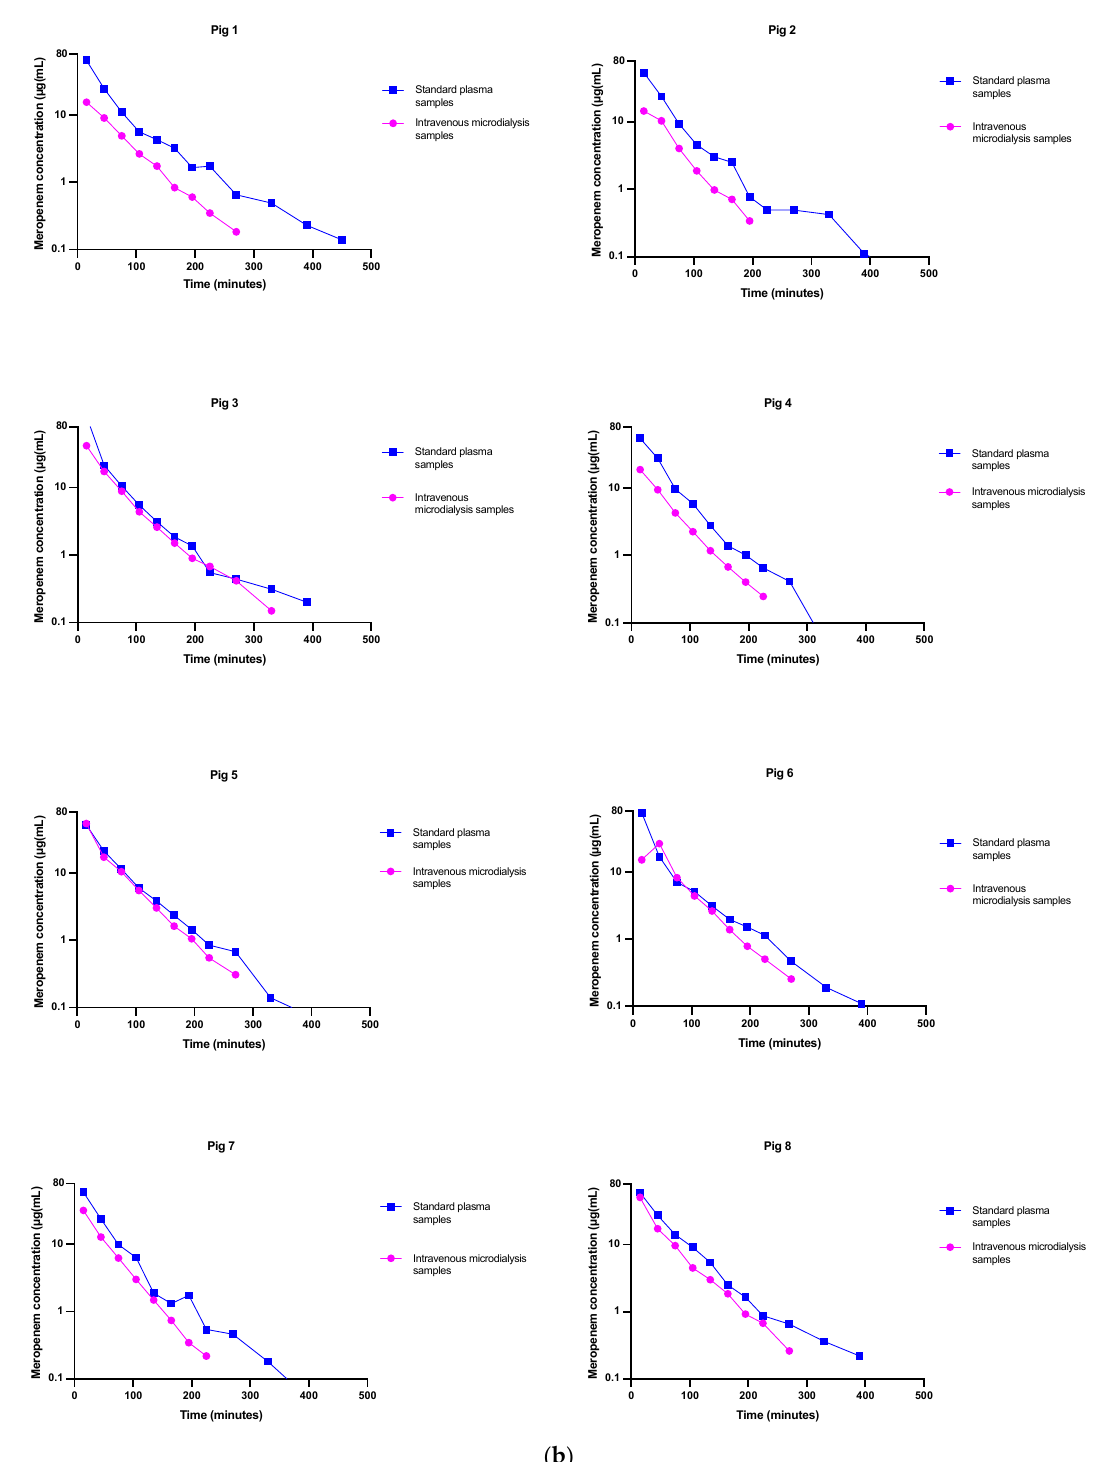
Figure 2. ( a ) Mean concentration–time profiles of meropenem obtained by standard plasma samples and intravenous microdialysis samples. Standard deviation (SD) is visualized with bars. The left Y -axis is log-scaled and shows a two-segmented axis in order to contain all values. Lower limits of quantification (LOQ) for the analytical methods are inserted for illustration. Values below this threshold should be cautiously interpreted. ( b ) Individual concentration–time profiles for standard plasma sampling and intravenous microdialysis sampling in pig numbers 1–8 for meropenem. The Y -axis is